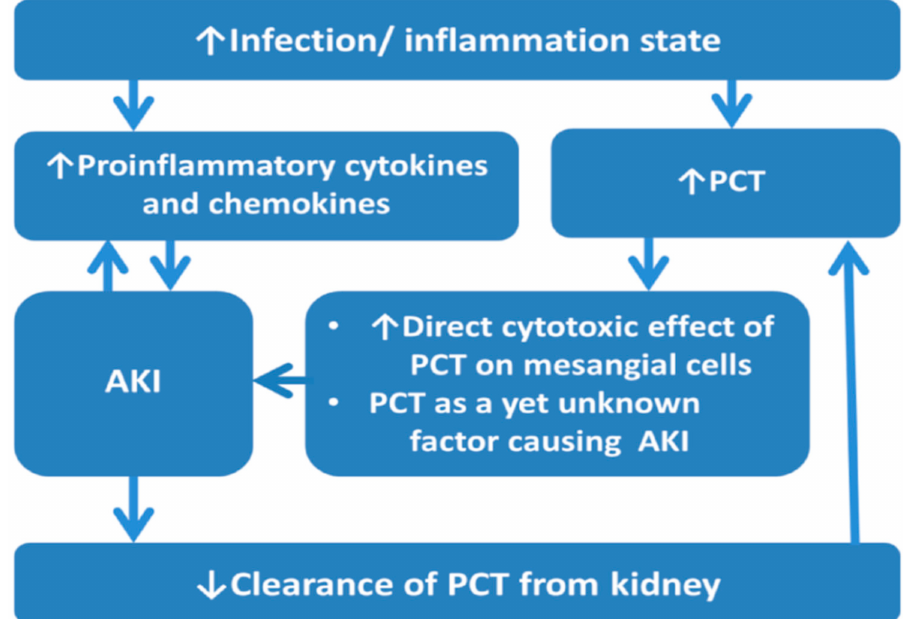
Figure 1. The association between PCT and AKI in infection/inflammation state. Abbreviations: AKI, acute kidney injury; PCT,